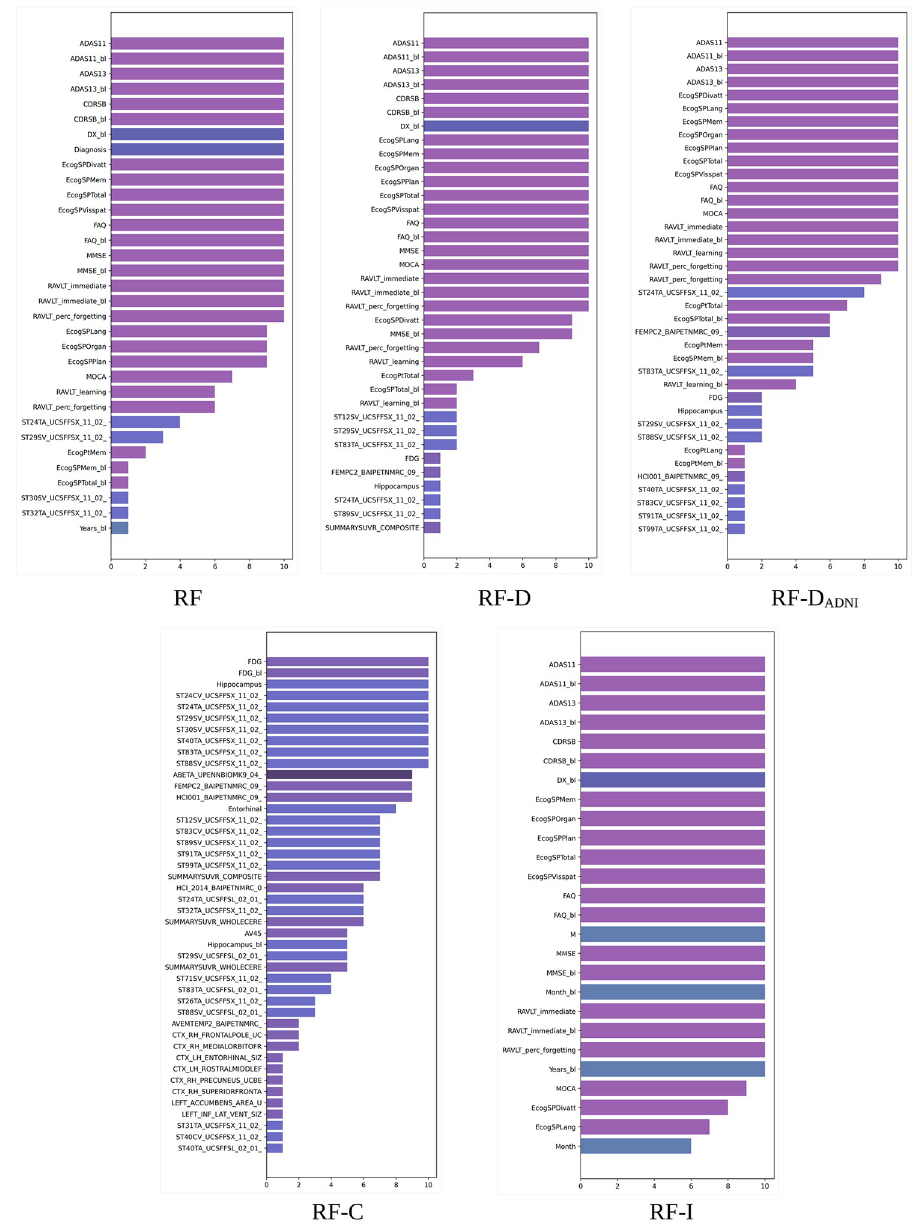
Fig 10. Robustness of SHAP importance for RF. Frequency of the top 25 features over 10 random experiments for the 100% training set. The bars are colored by feature type (diagnosis, clinical, cognitive, MRI, PET, DTI, APOE4, and proteomic